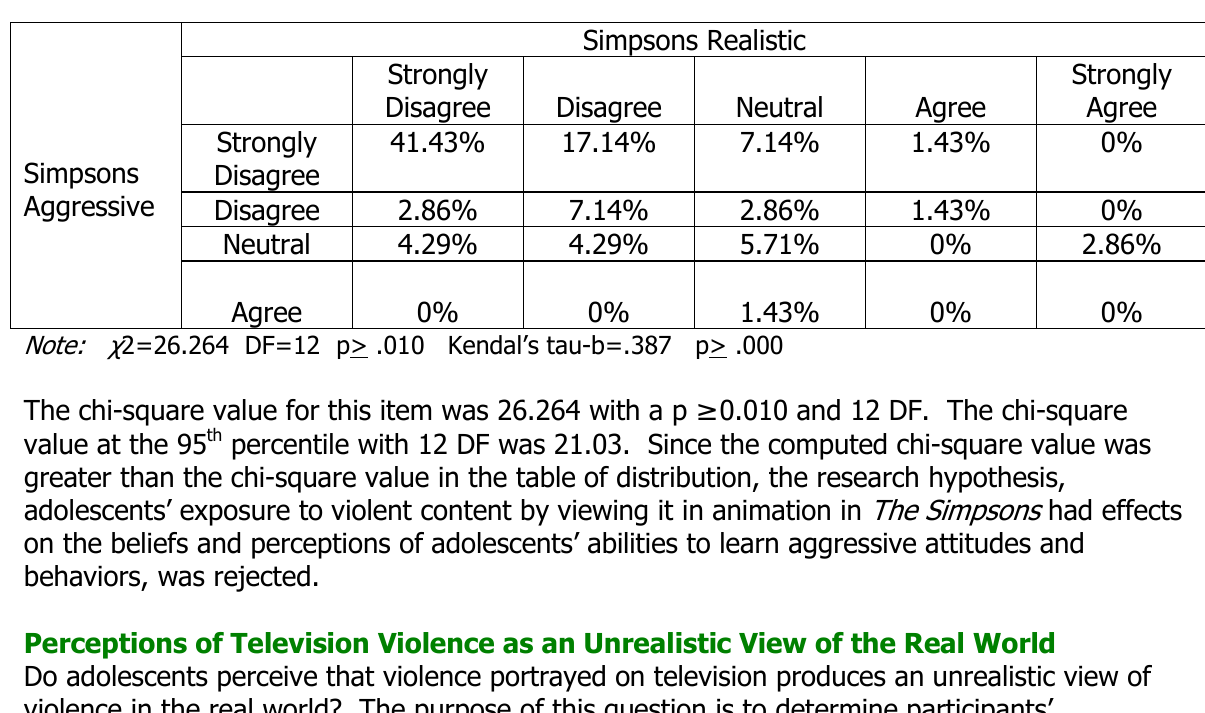
Comparison of after I watch violence on The Simpsons I become aggressive and violence on The Simpsons is realistic Cross